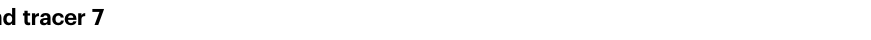
Fig.2|Comparisonoftracer1andtracer7intermsofbindingaf fi nity,binding mode and resolution of the FP assay. a Isothermal titration calorimetry (ITC) experiments for the binding of tracer 1 to APC. N : the number of sites per APC, K : the binding constant between APC and tracer 1, Δ H : heat change, Δ S : entropy change.Thedatashownarerepresentativeofthreeindependentexperiments.The upperplot presents the ITCraw data,and the lower plot presents fi ttedintegrated peakareas. b ITCexperimentsforthebindingoftracer7toAPC. c Characterization and cocrystal structure of the tracer 7 – APC complex (PDB code: 7F7O). APC is shownasasolvent-accessiblesurface(gray),andtracer7isdepictedbysticks(pink